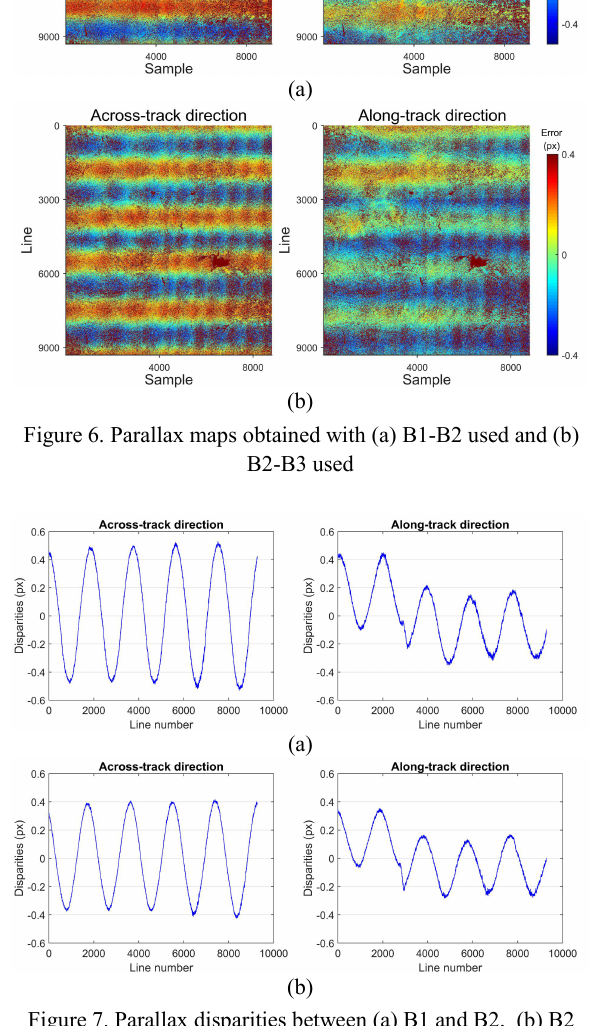
Figure 7. Parallax disparities between (a) B1 and B2, (b) B2 and B3, respectively